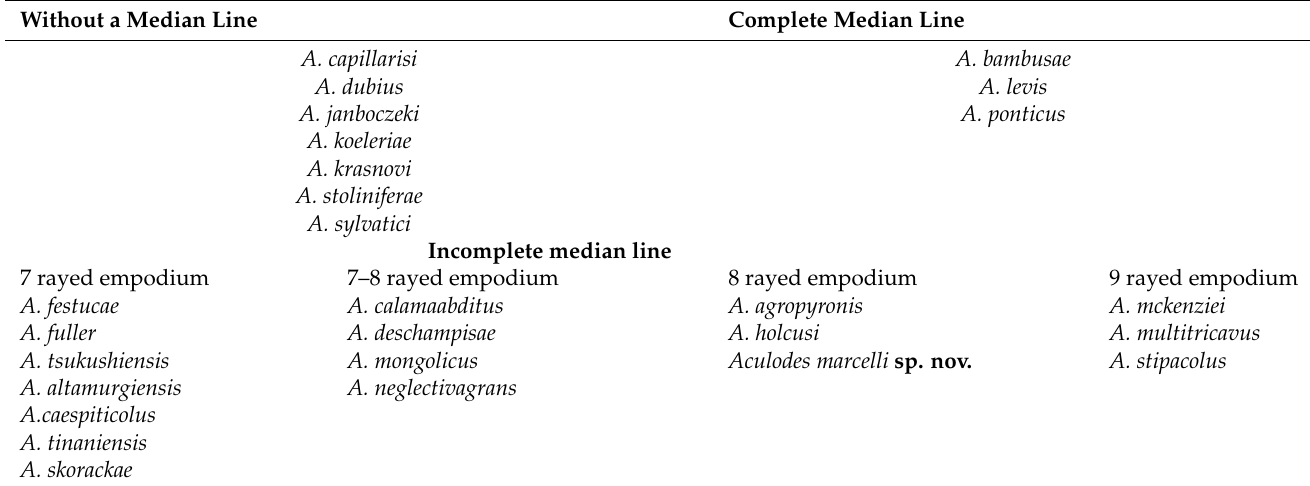
Table 4. Design of prodorsal shield and number of empodial rays of species in the genus Aculodes from